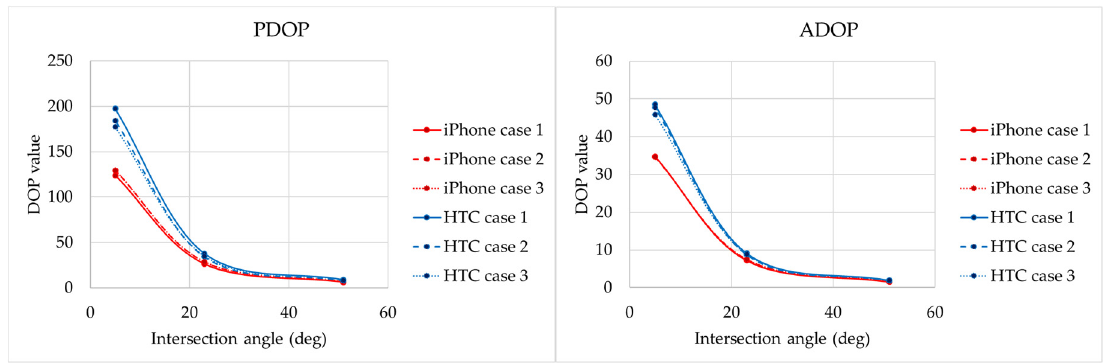
Figure 8. The DOP values of intersection angle analysis for two smartphones.